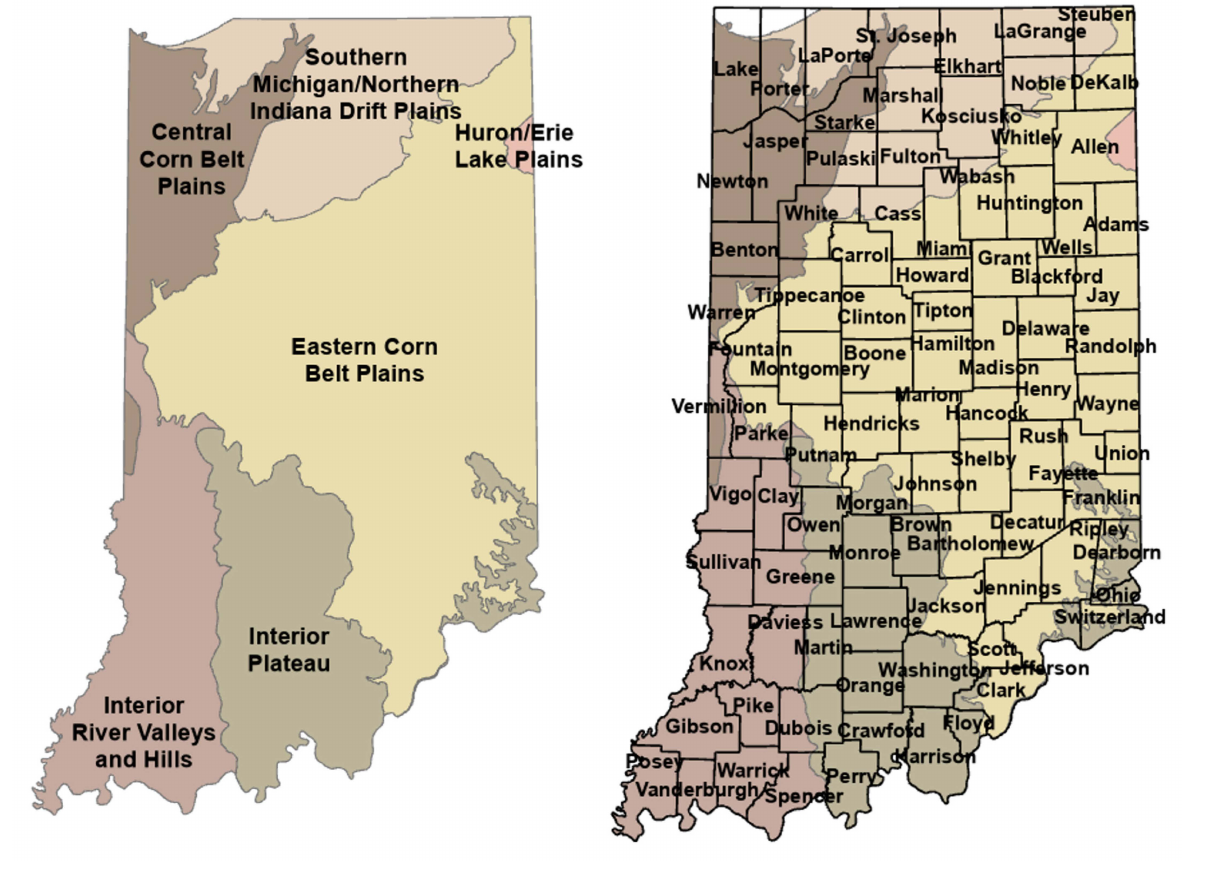
Figure 1. Indiana Ecoregions by County.